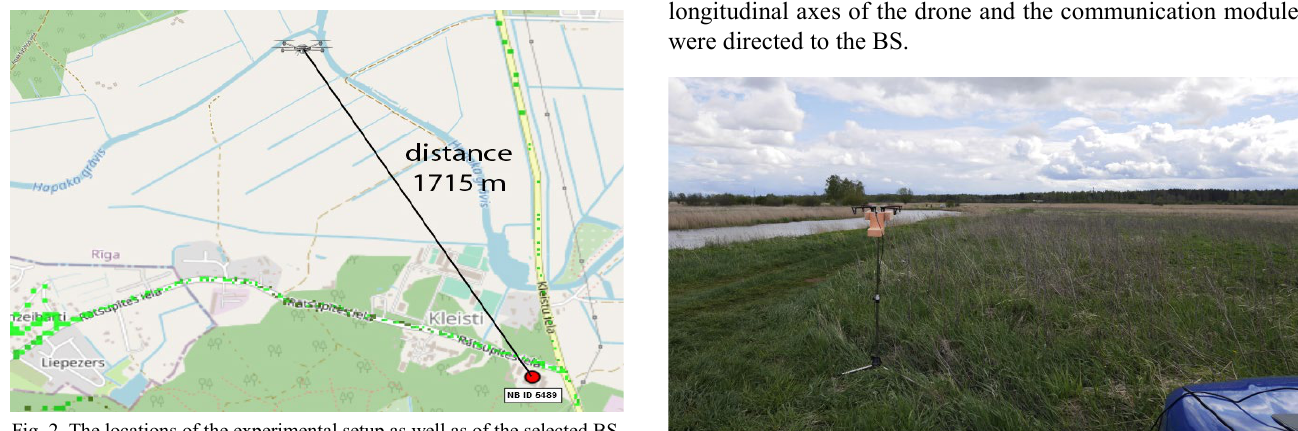
Fig. 2. The locations of the experimental setup as well as of the selected BS.